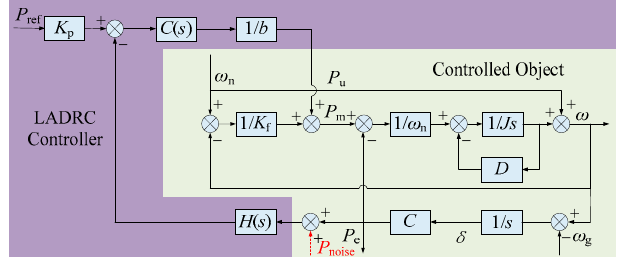
Figure A1. Control structure for the power of the VSG based on LADRC when the measurement noise is considered.